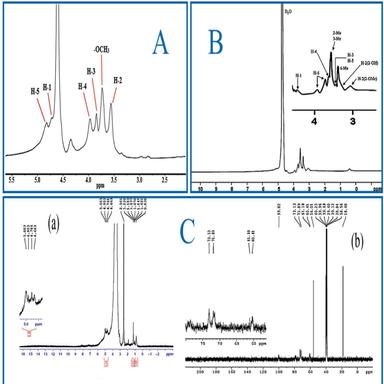
NMR analysis of, (A)Pectin using H NMR, (B)1H NMR of 2,3,6-tri-O-methylcellulose obtained from sugarcane bagasse cellulose , (C)Pullulan obtained from cassava bagasse (a) 1H NMR and (b) 13C NMR for pullulan .